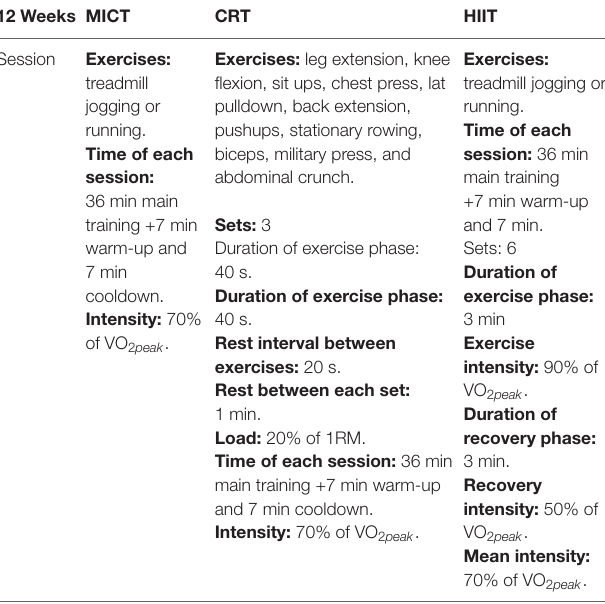
TABLE 1 | Exercise protocols by group (MICT, CRT, and HIIT) and by intensity and duration for each weekly session. 12 Weeks MICT CRT